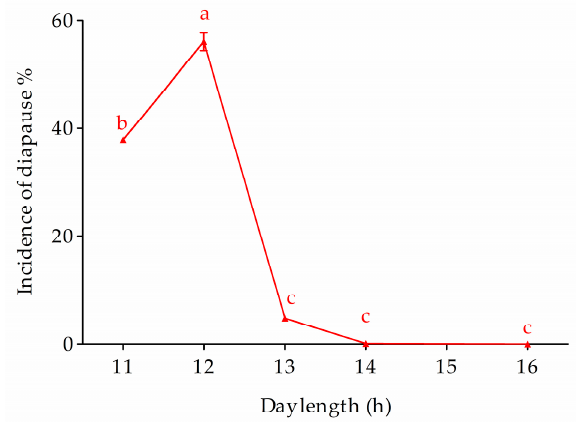
Figure 7. Photoperiodic response of Ln under a diapause inducing temperature (24 °C). Symbols and bars represent the mean ± SE values. Different lowercase letters indicate significant differences ( p < 0.05) among diapause incidence of the photoperiodic response of Ln strain.